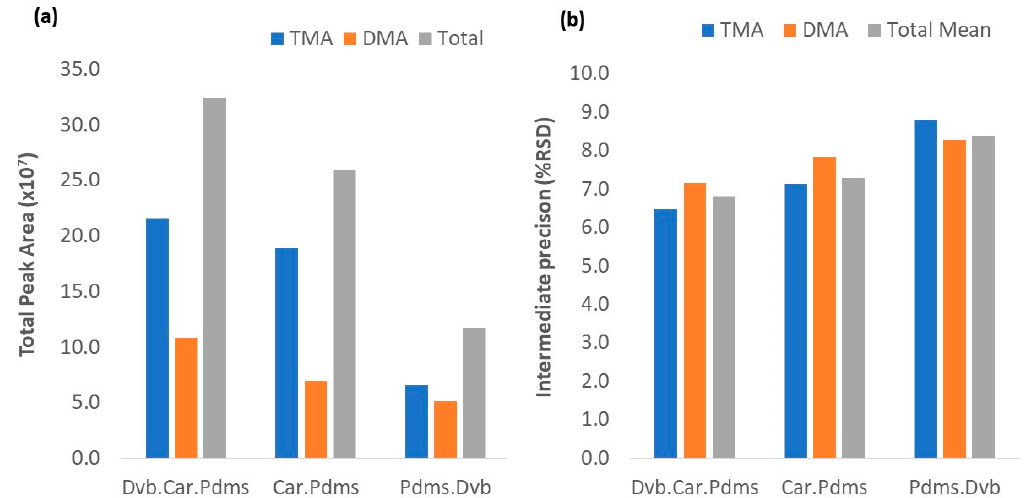
Figure 1. Results from the HS-SPME knowledge space of extraction conditions ( a ) Total peak area analysis for all fibers; ( b ) Intermediate precision for all assayed fibers.